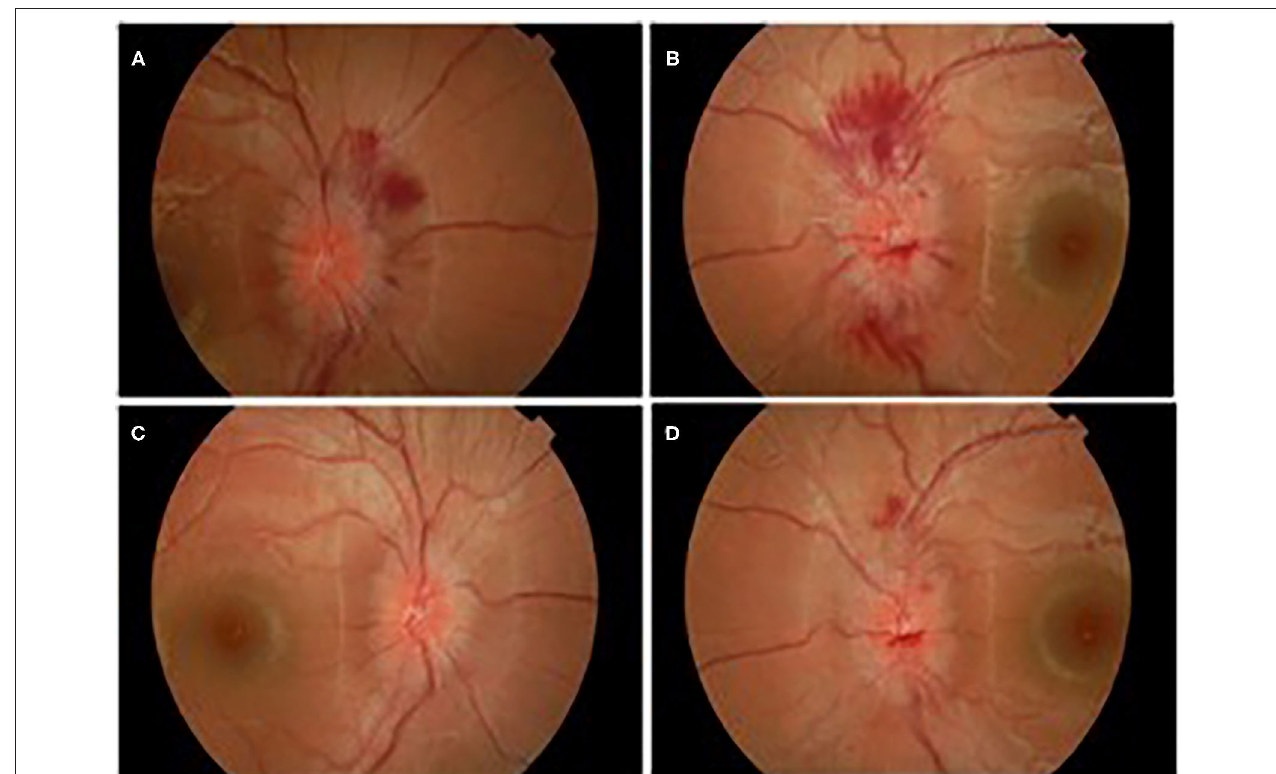
FIGURE 3 | Ocular edema with flamed shaped hemorrhages OD (A) , OS (B) , and gradual improvement after treatment OD (C) , OS (D) .